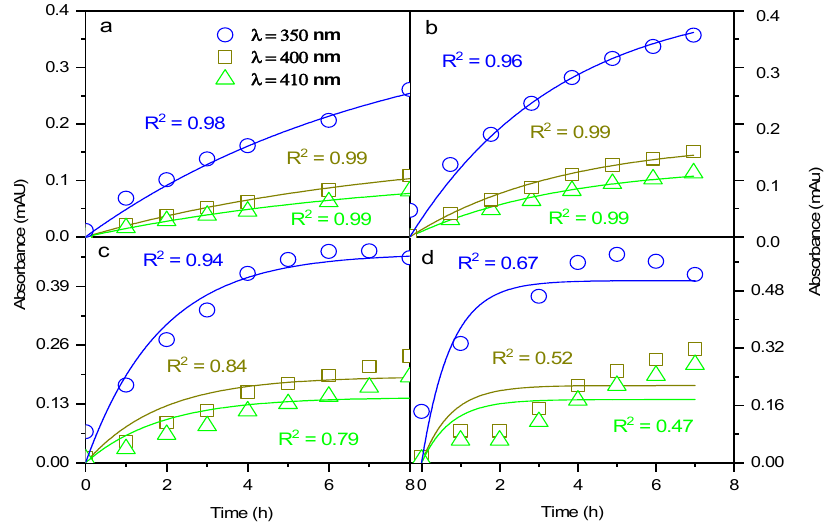
Figure 6. BrC formation in the reaction mixture of 0.1 mM 3-methylcatechol and ( a ) 0.5, ( b ) 1, ( c ) 2, and ( d ) 5 mM NaNO 2 under sunlight conditions. Experimentally measured (symbols) and modelled absorbance (solid lines) at different wavelengths, representative of BrC are shown. In contrast to the illuminated experiments, the model describes the experimental data of dark reactions very well, also at high NaNO 2 concentrations (0.1 mM 3MC and 2 mM NaNO 2 ; Figure 7). These results additionally support our discussion that under the sunlight, the formed BrC species undergo secondary reactions substantially. 0 Time(h) R 2 = 0.99 Figure 7. BrC formation in the reaction mixture of 0.1 mM 3-methylcatechol and 2 mM NaNO 2 in the dark. Experimentally measured (symbols) and modelled absorbance (solid lines) at different wavelengths, representative of BrC are shown. From characteristic MAC values at 350, 400, and 410 nm listed in Table 3 one can see that with increasing NaNO 2 concentration, higher MAC values are obtained corresponding to more BrC production; i.e., the highest was in the order of 4 m 2 g − 1 for 5 mM NaNO 2 at 350 nm. It should be